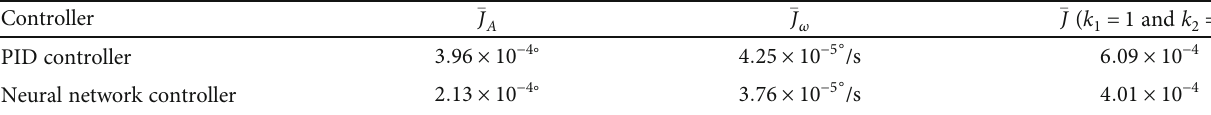
Figure 9: Angular velocity error under the control of neural network. Table 9: Performances of staring at all the ground targets.